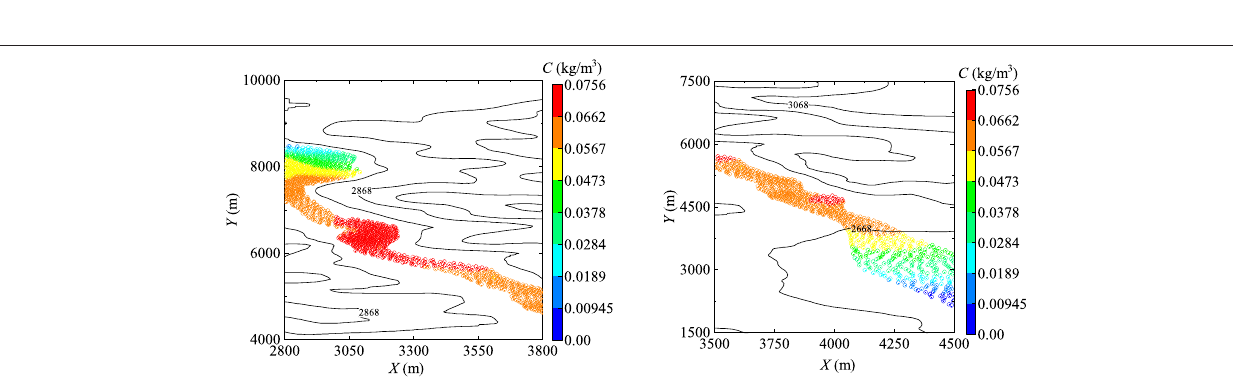
FIGURE 9 | Pollutant concentration distribution map after the Nanmenxia dam break under variable diffusion coef fi cients.